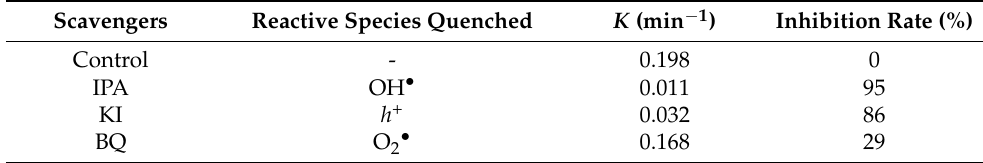
Table 3. The inhibition characteristics of different scavengers’